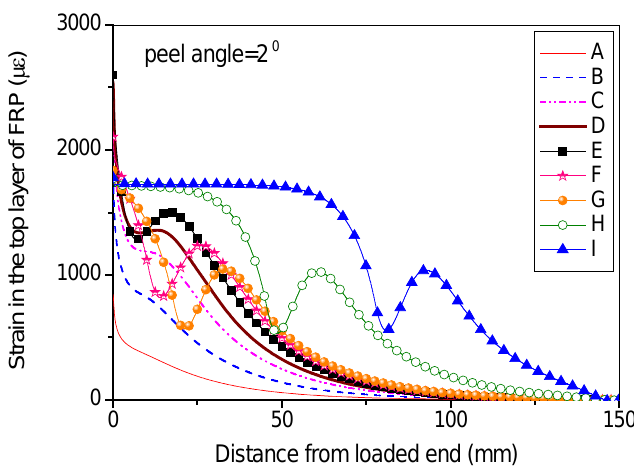
Figure 17. Strain distributions along the surface of FRP lamina when the peel angle = 2 degree.